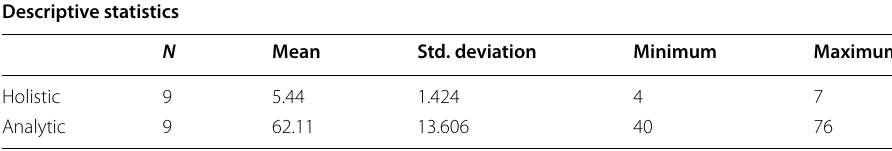
Table 4 Wilcoxon signed-rank test for the two scales Test statistics a